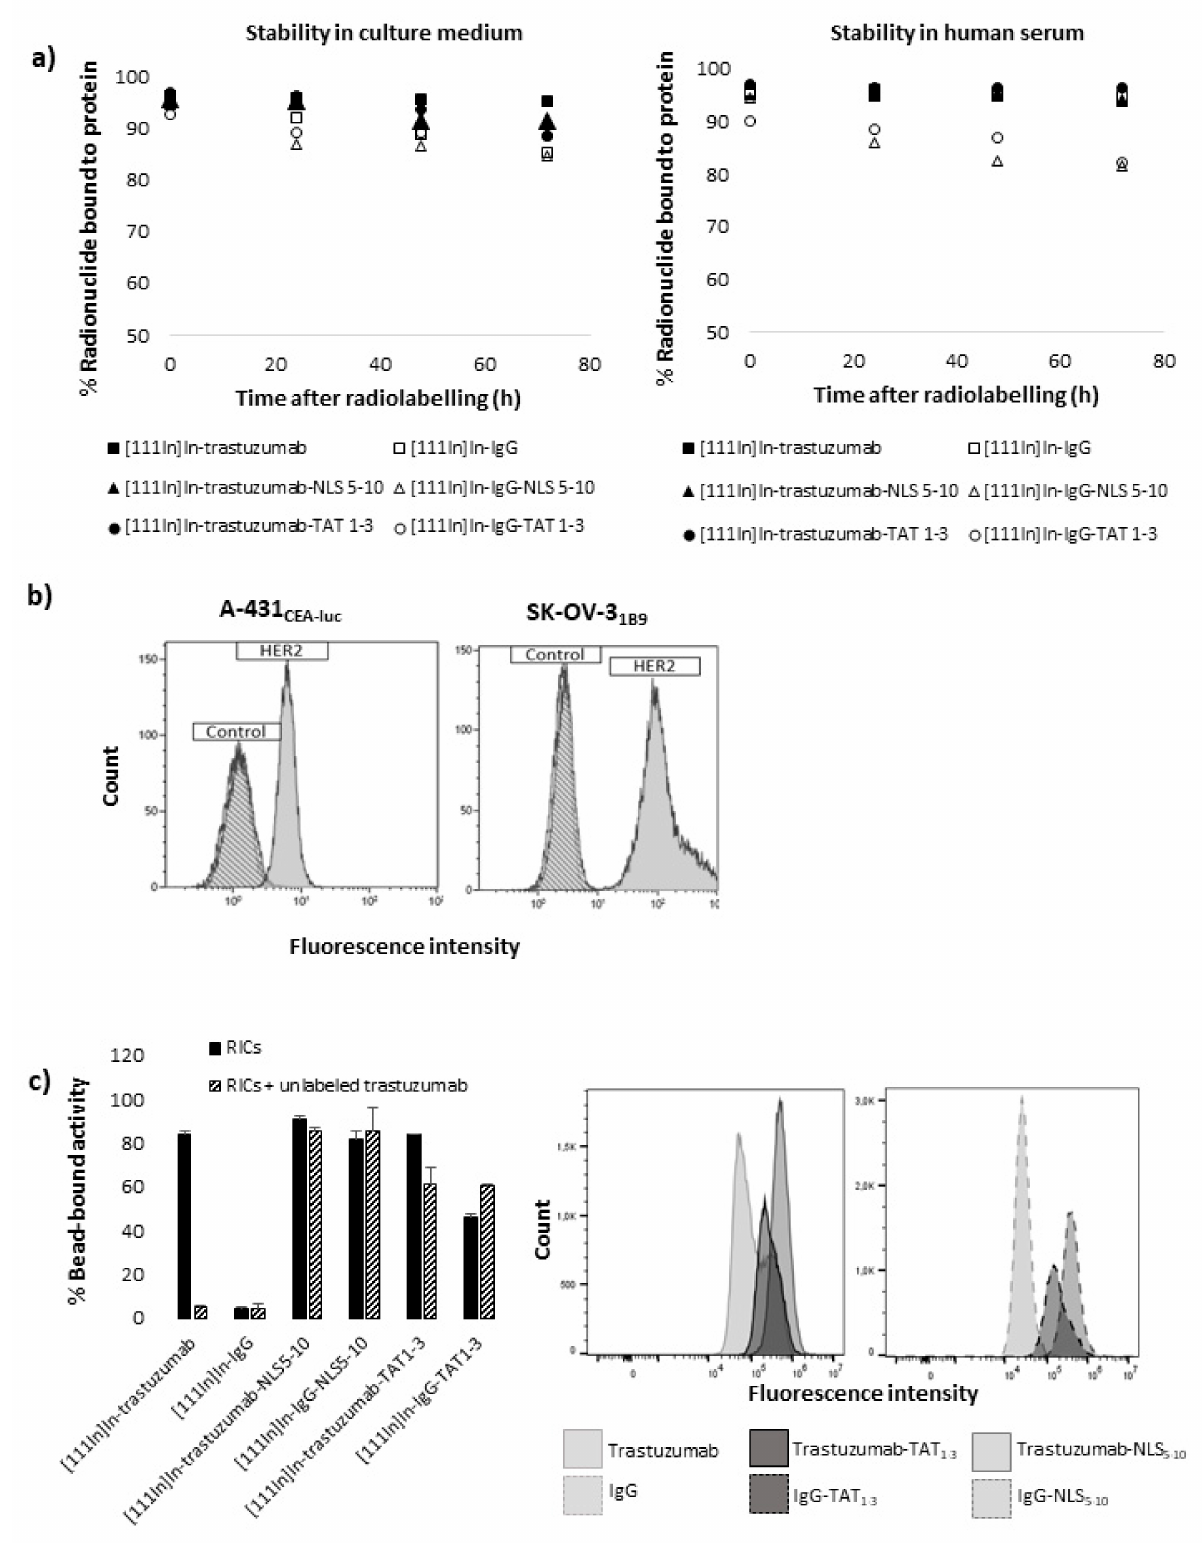
Figure 2. Stability and immunoreactivity of immunoconjugates, HER2 expression. ( a ) In vitro stability of radioimmunocon- jugates. ( b ) HER-2 expression on A-431 CEA-luc and SK-OV-3 1B9 cells evaluated by flow cytometry. ( c ) Immunoreactivity assessment using HER2-coated beads ( left panel). Flow cytometry assessment of cell binding using a secondary FITC- labelled anti-human IgG antibody ( right